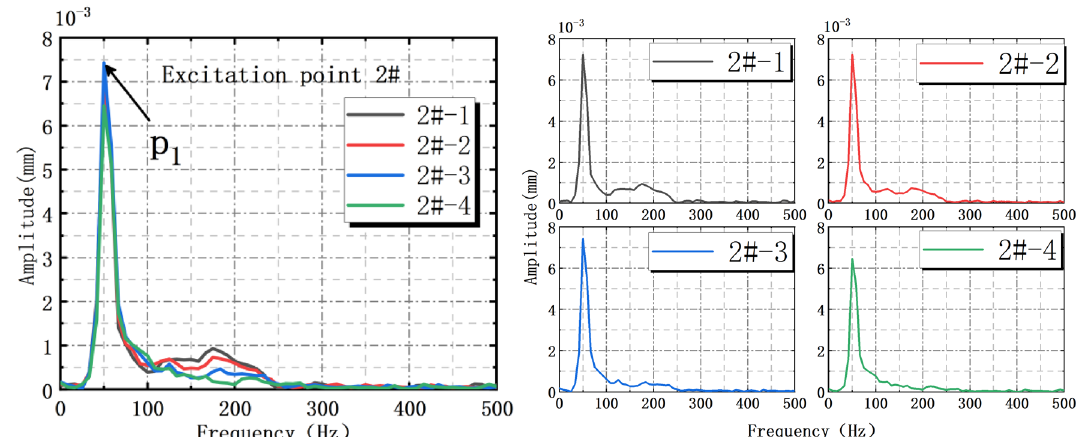
Figure 7. Amplitude-frequency distribution of interface vibration under 2# action point